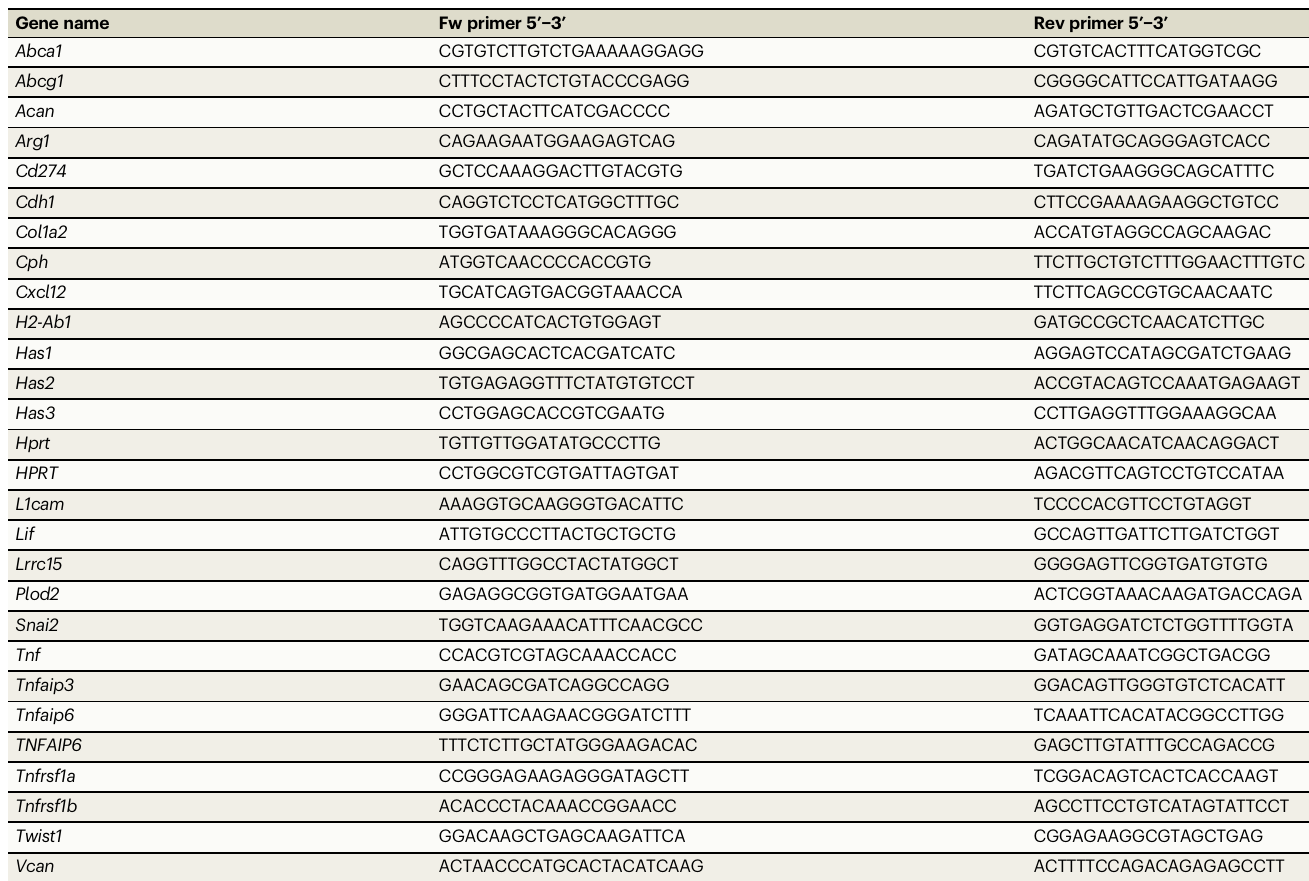
Table 1 | Primers for qRT-PCR Gene name